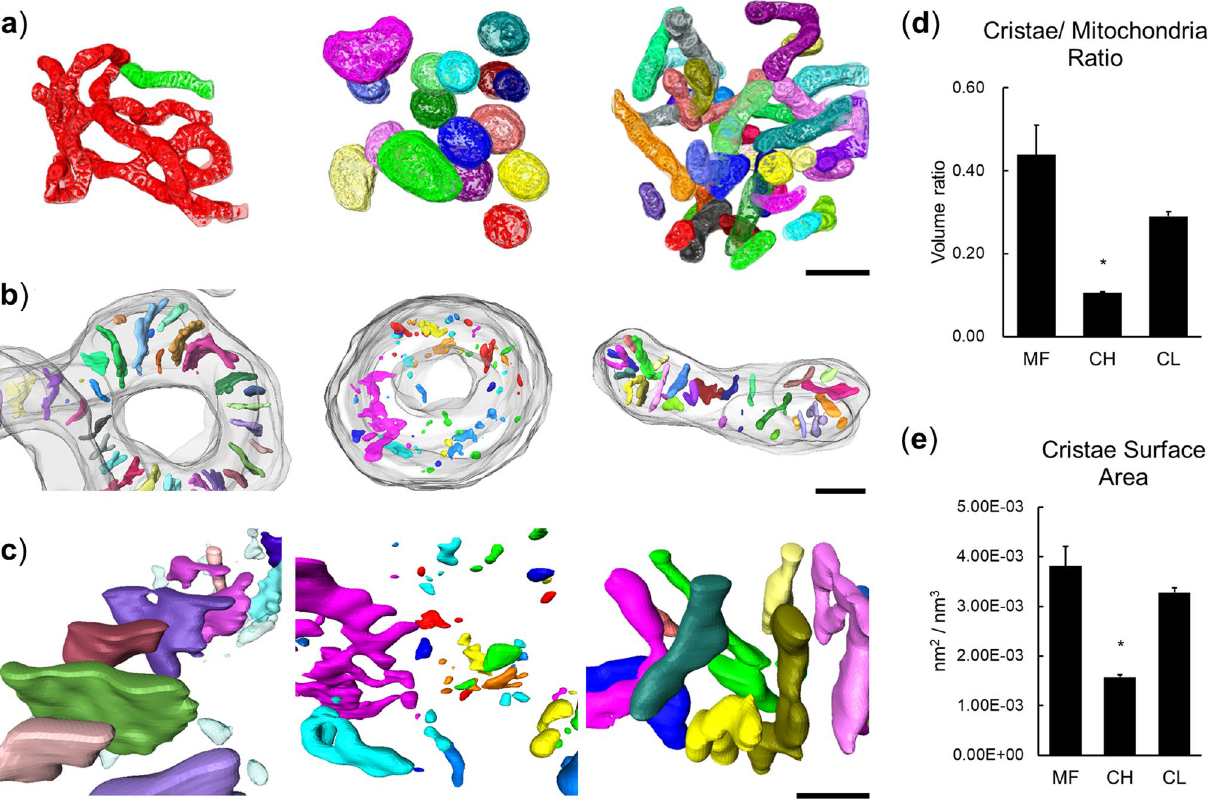
Figure 7. Visualization and quantitative analysis of mitochondrial networks with COX-positive signal in the goat LLC lineage. ( a ) Mitochondria with COX signals in GC (left), LLC in CH (middle) and LLC in CL (right). The mitochondria without physical connections are labeled with different colors. Bar: 1 μm. ( b ) Representative distributions of cristae COX signals (colored segments) in the mitochondria (gray) from GC (left), LLC in CH (middle), and LLC in CL (right). Bar: 0.2 μm. ( c ) The structure of cristae at higher magnification. Left: GC. Middle: LLC in CH. Right: LLC in CL. Bar: 0.1 μm. ( d ) The average volume ratio between the cristae